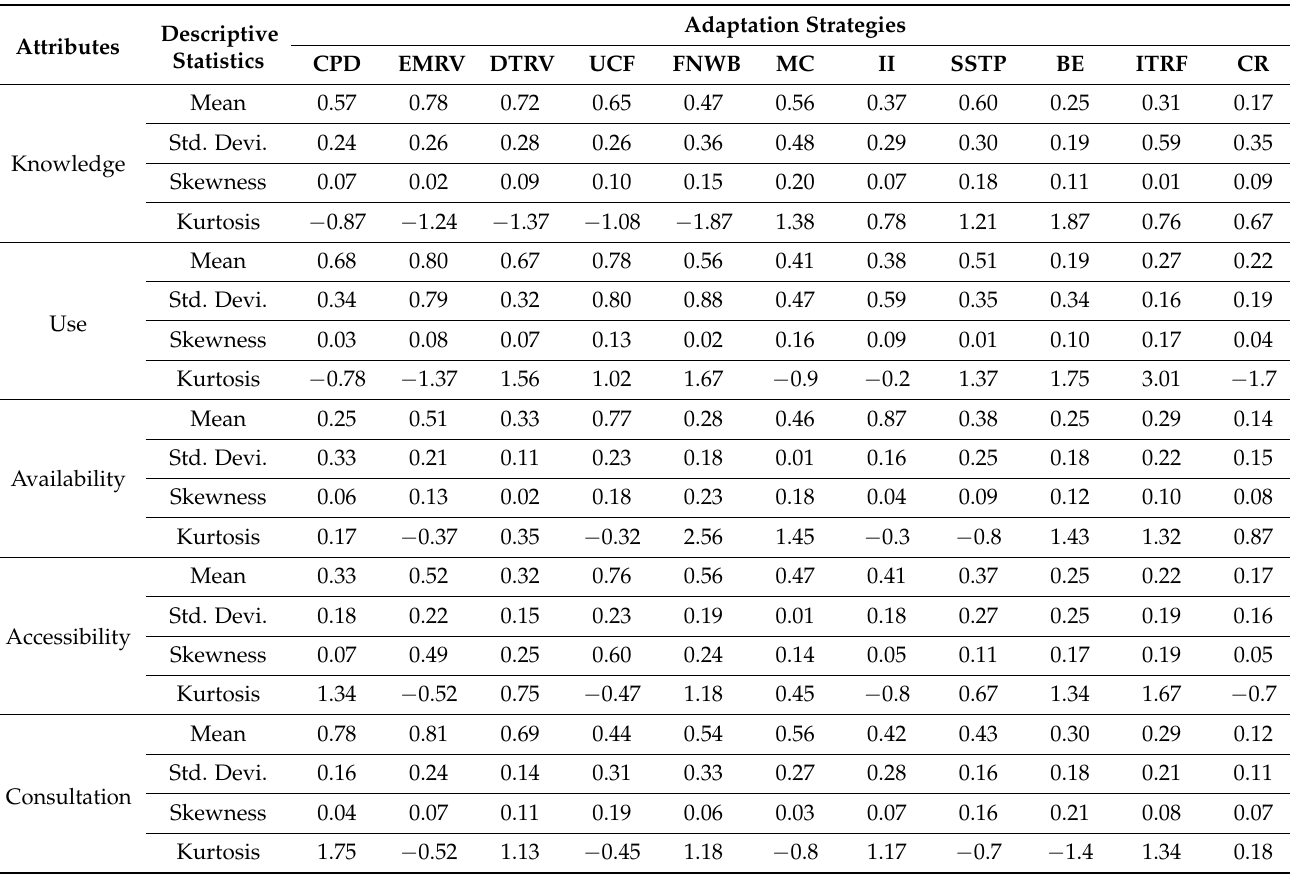
Table 5. Attributes that differentiate between low and high adaptive